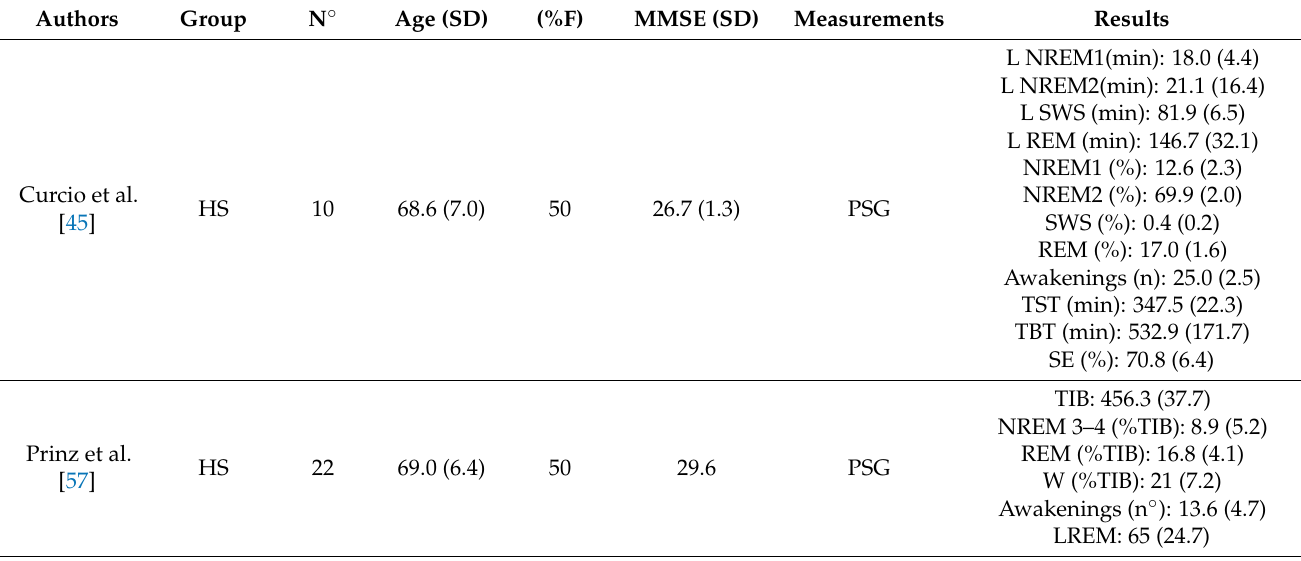
Table 3. Sleep in older age. Summary of all the studies that use